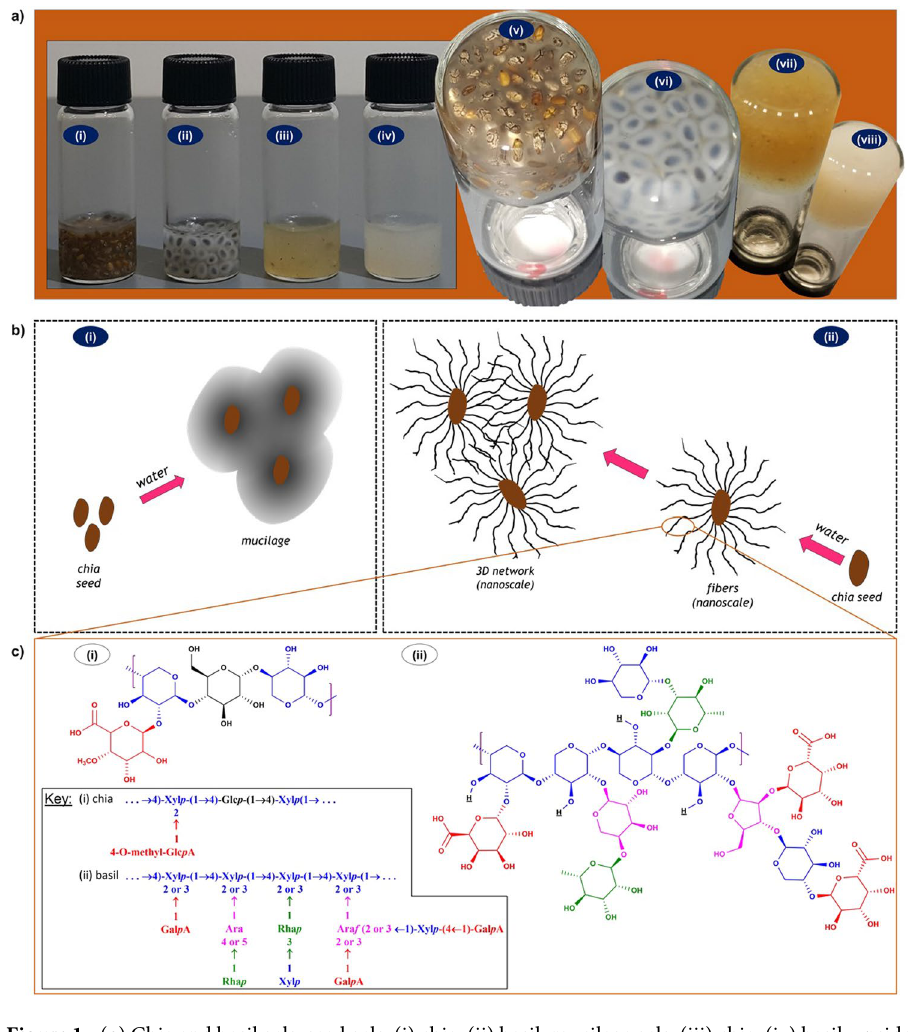
Figure 1. ( a ) Chia and basil gels; seed gels: (i) chia, (ii) basil; mucilage gels: (iii) chia, (iv) basil; upside down: (v, vii) chia, (vi, viii) basil. ( b ) Illustration of gelation based on the current notion and our hypothesis; (i) Current notion: gel formation is merely due to the seed’s mucilage swelling in or coagulating water; (ii) Hypothesis: mucilage of chia contains nanoscale fibers that extend in water to form 3D network, entrapping and “congealing” water to form a gel. ( c ) chemical structures of reported compositions 20,21 : (i) chia repeating oligomer; (ii) basil repeating oligomer.